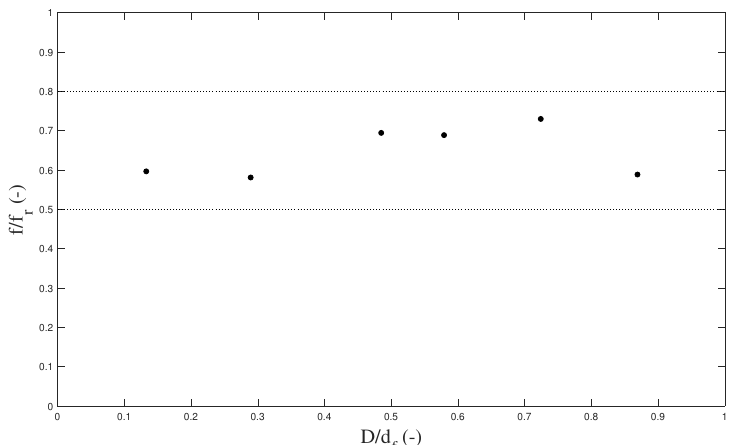
Figure 11. Dimensionless frequency in which the maximum (normalised) pressure occurs at r = 40 m as a function of the dimensionless diameter of the pile for d f = 6.9 m. The rest of the parameters are the same as in Table